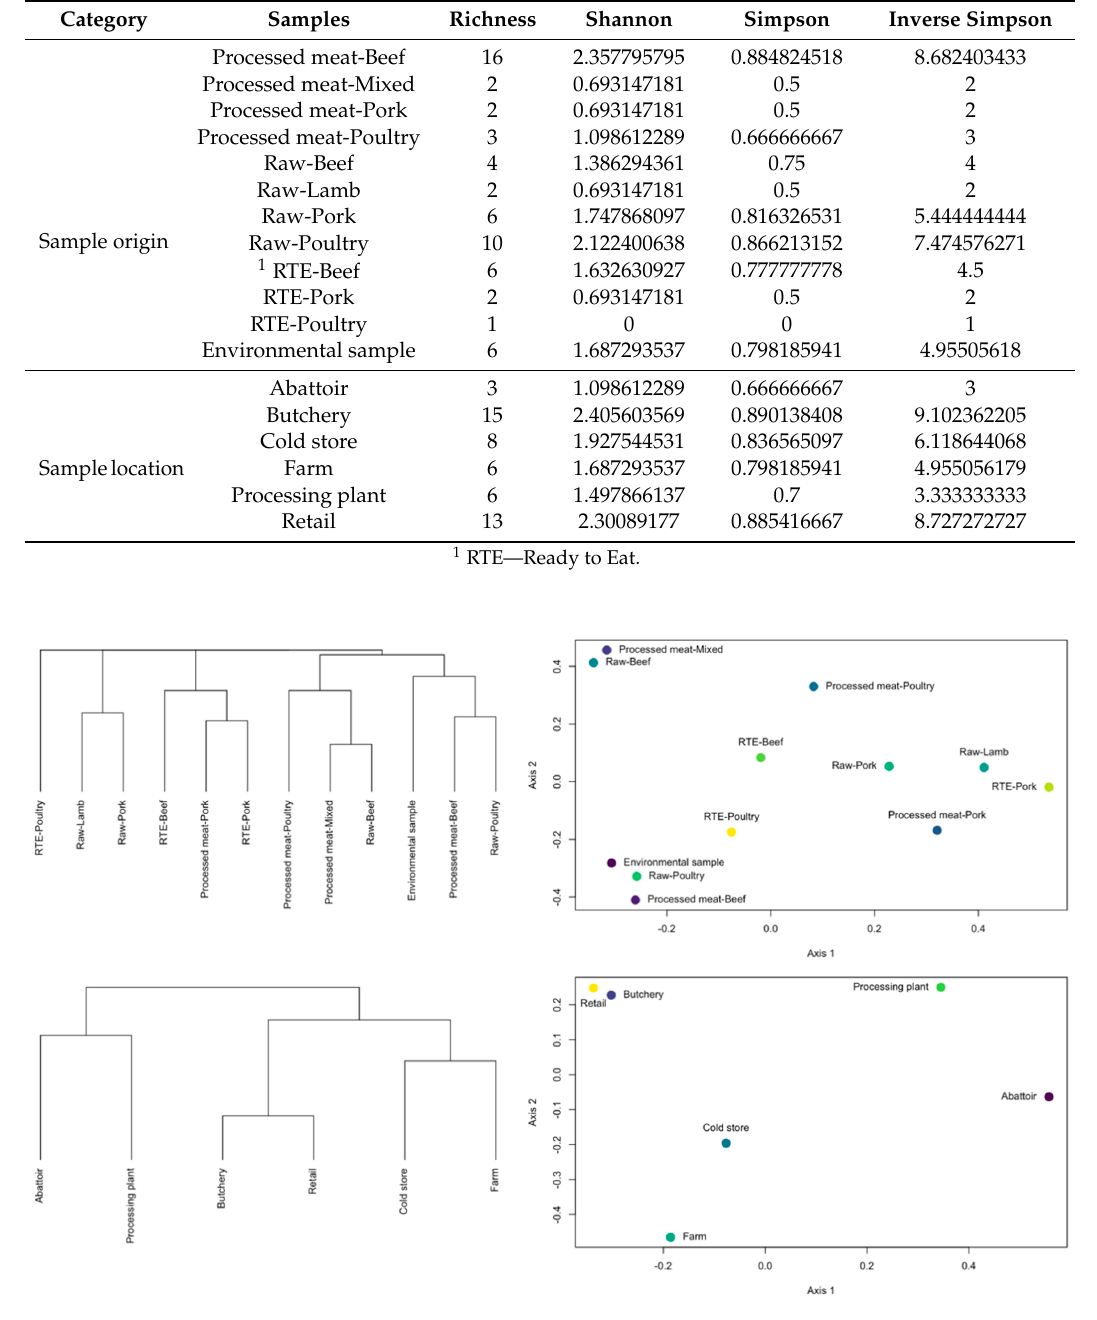
Table 2. Diversity indices based on the occurrence of STs in the di ff erent categories.